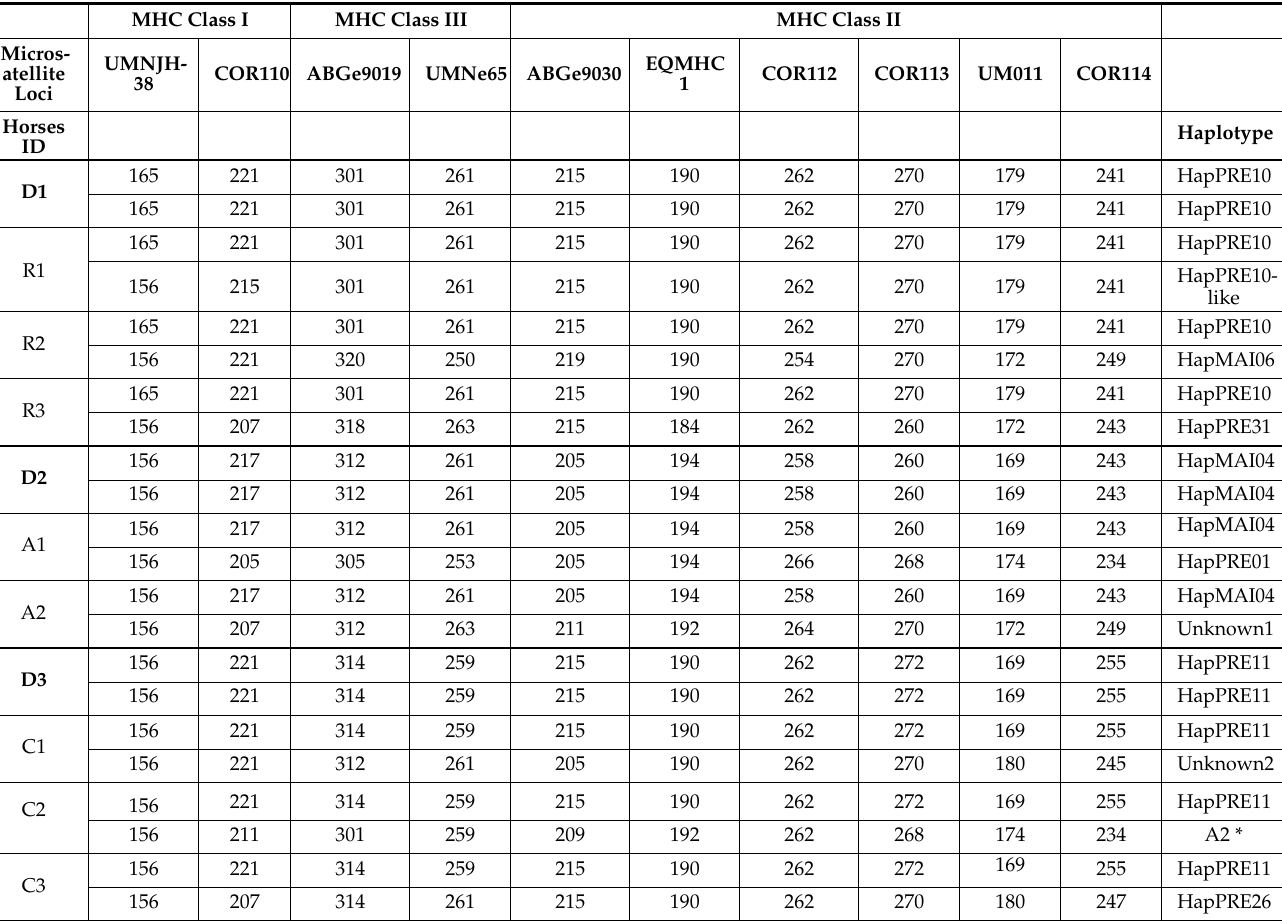
Table 1. List of major histocompatibility complex (MHC) microsatellite haplotypes identified in the horses enrolled in the